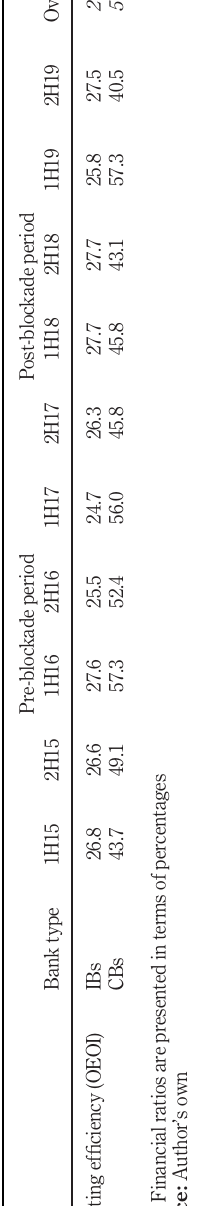
Table 4. Period-and-group- wise comparison of bank efficiency